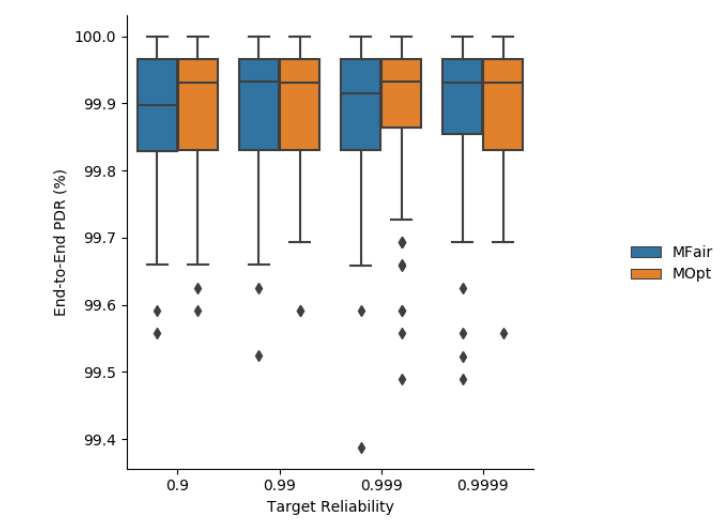
Figure 7. End-to-end delivery rate obtained with MFair and MOpt